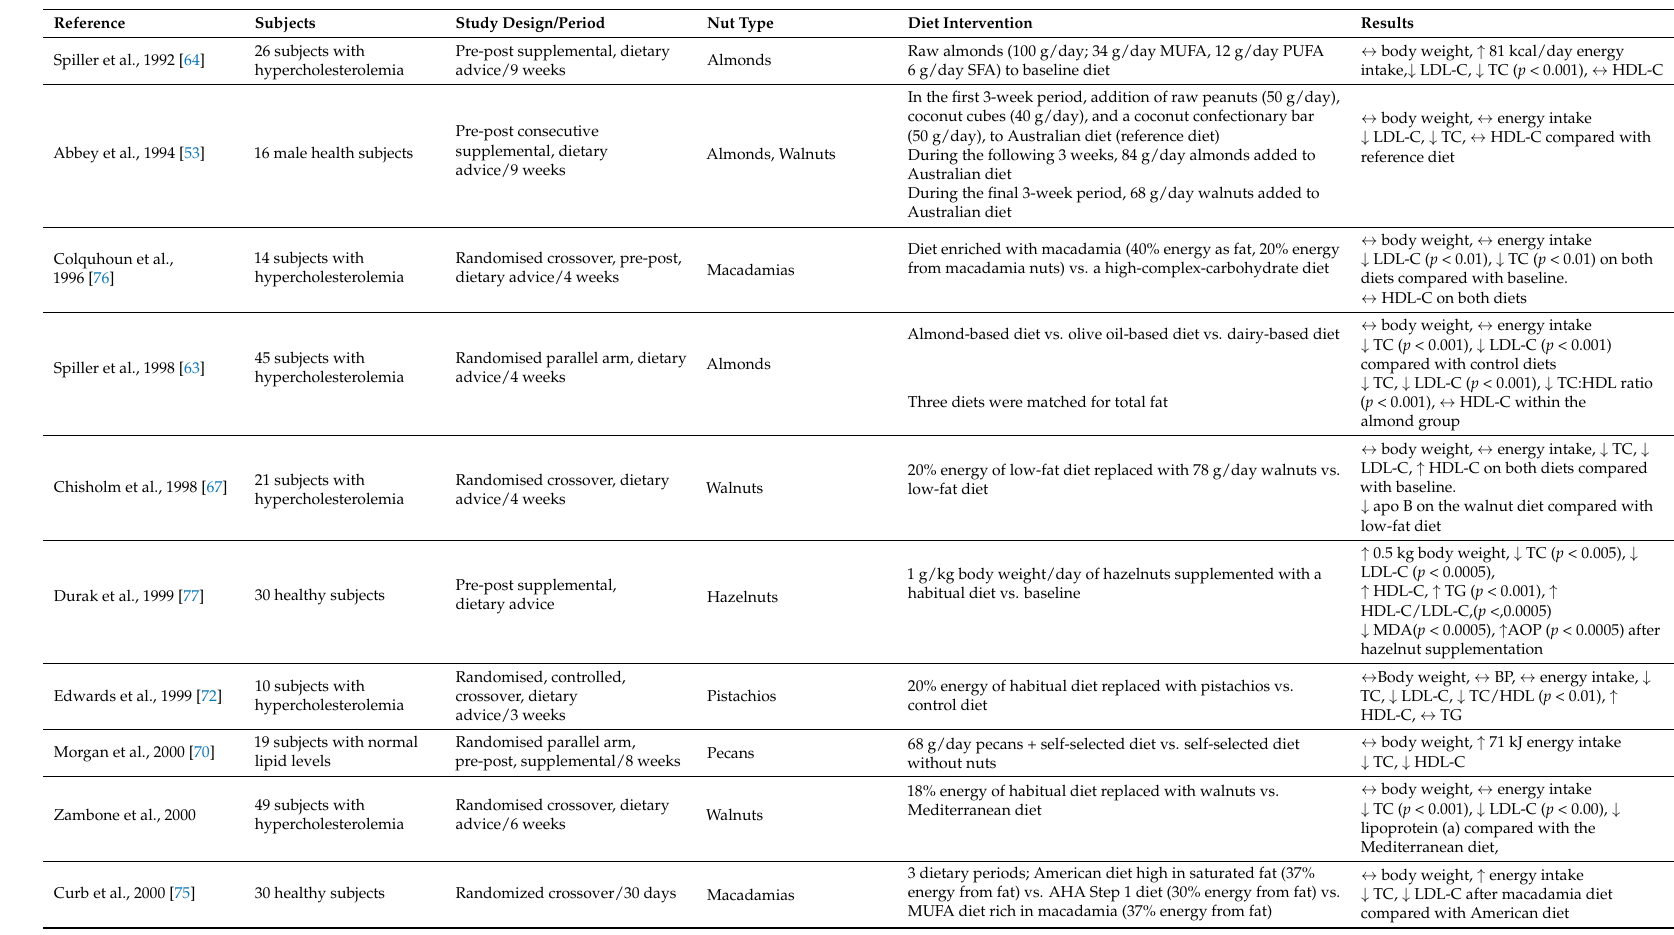
Table 3. Summary of clinical trials examining the effect of nut consumption on body weight